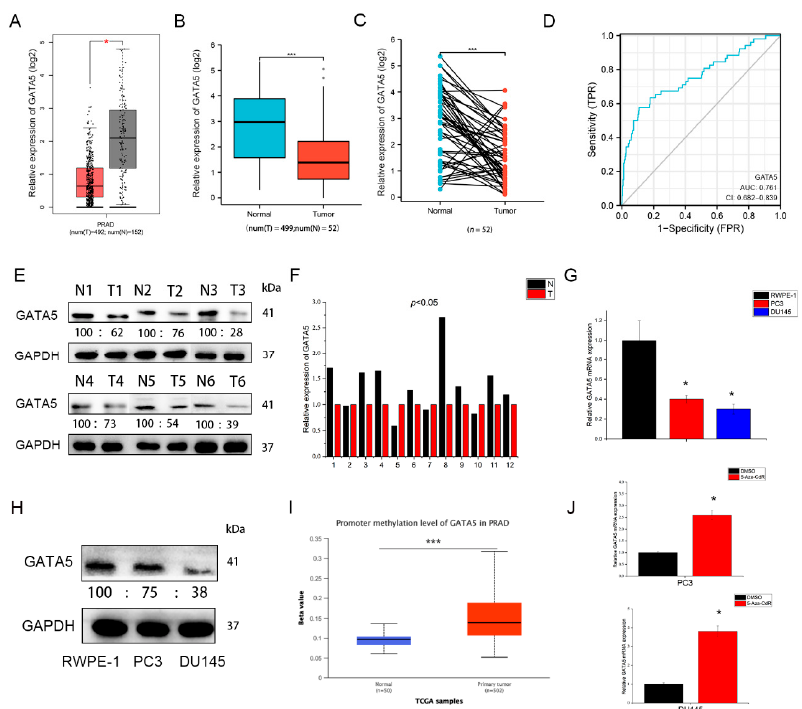
Figure 1. GATA5 is downregulated in both PCa samples and PCa cell lines. ( A ) GEPIA of GATA5 expression in 492 tumor and 152 normal tissues. ( B ) GATA5 expression was identified in 499 tumor and 52 normal samples from TCGA. ( C ) Expression in 52 pairs of tumorous and pericarcinomatous tissues from TCGA. ( D ) ROC analysis results of GATA5. ( E ) Western blotting showed the GATA5 expression in PCa and adjacent tumor tissues. ( F ) Relative mRNA expression of GATA5 in PCa and adjacent tumor tissues. ( G , H ) GATA5 was downregulated at both the mRNA and protein levels in PCa cell lines compared to RWPE-1 cells. ( I ) Promoter methylation level of GATA5 in PCa from TCGA. ( J ) The level of GATA5 mRNA in PCa cell lines after treatment with 5-Aza-CdR (5 µM) for 24 h. Data are presented as mean ± SD of at least three experiments. * p < 0.05 and *** p < 0.001.